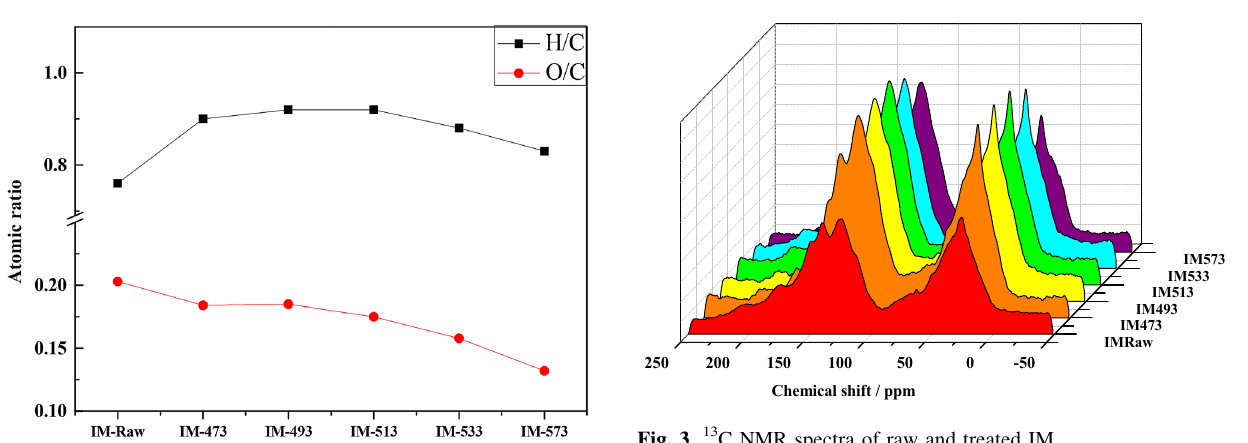
Fig. 3 13 C NMR spectra of raw and